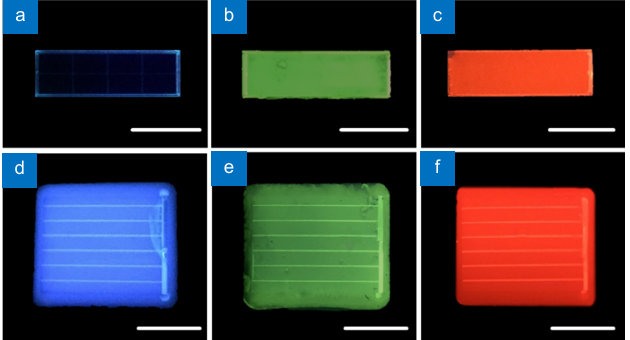
Fig. 1 | Photographs of the (a, d) bare PV devices and of the coated (b, c) PV-1 and (e, f) PV-2 with the (b, e) dU6-Tb and (c, f) tU5-Eu LDS layers, under UV radiation at 365 nm . Scale bars: 10 − 2 m.